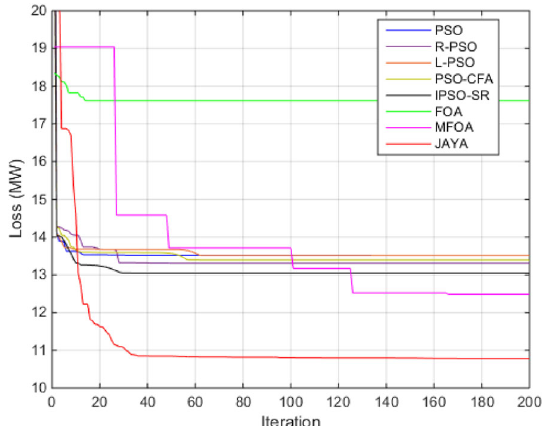
Fig. 12 Convergence characteristics of the algorithms for the IEEE 57 bus system with